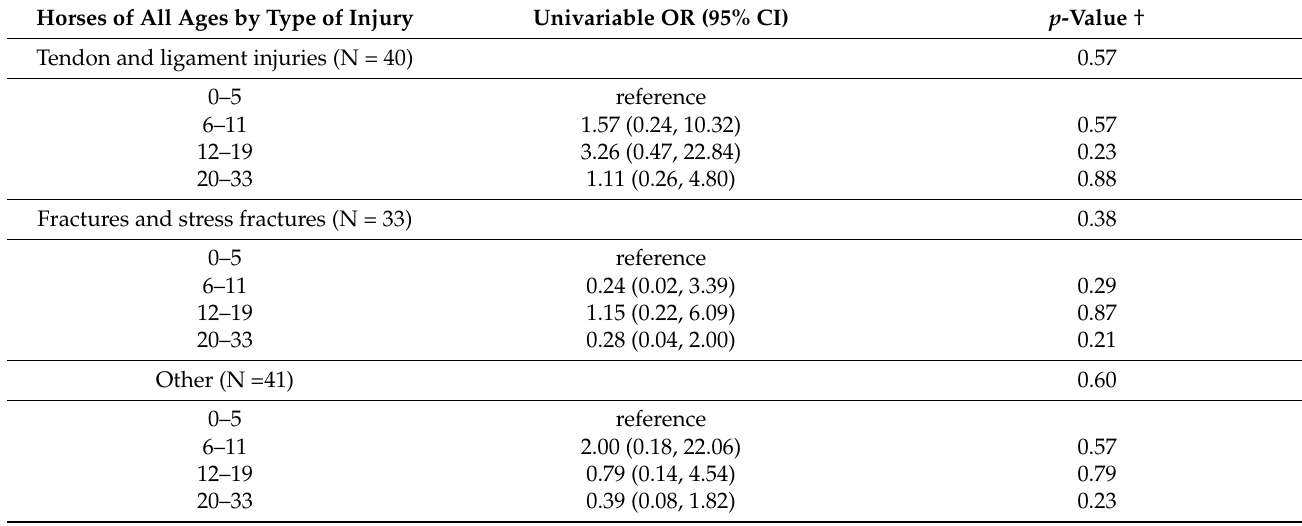
Horses of All Ages by Type of